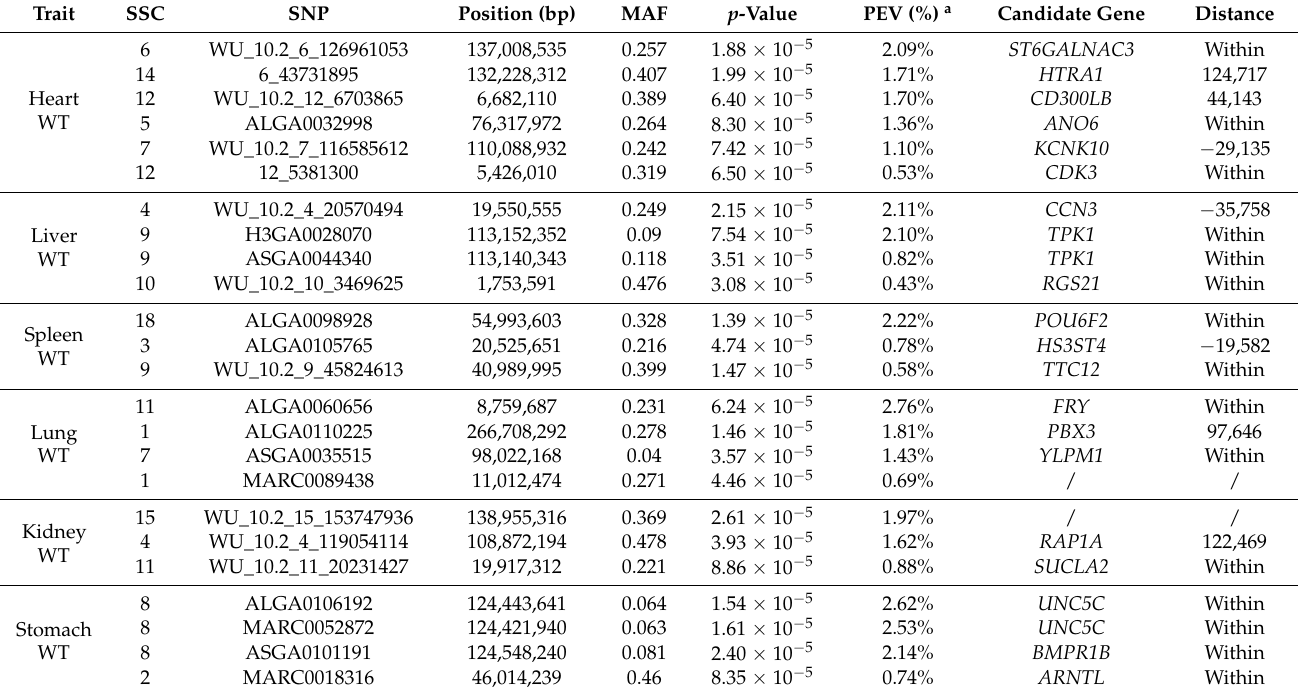
a The percentage of phenotypic variance explained by each